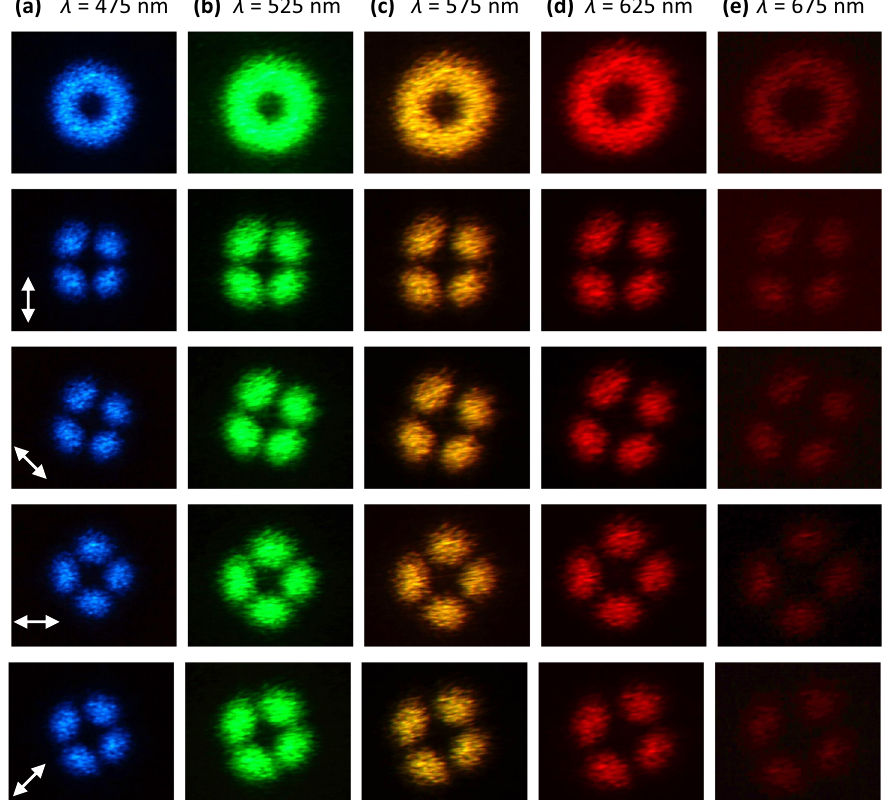
Fig. 6 Broadband characterization of the vectorial metasurfaces designed for a fi eld pro fi les with l = − 2, m = 0. The measured intensity pro fi les at different wavelengths of a λ = 475 nm, b λ = 525 nm, c λ = 575 nm, d λ = 625 nm, e λ = 675 nm. Top row: measured intensity pro fi les without linear polarizer. Second to fi fth rows: measured intensity pro fi les with a linear polarizer. The white arrow represents the transmission axis of the linear polarizer. NATURE COMMUNICATIONS| (2021) 12:3631